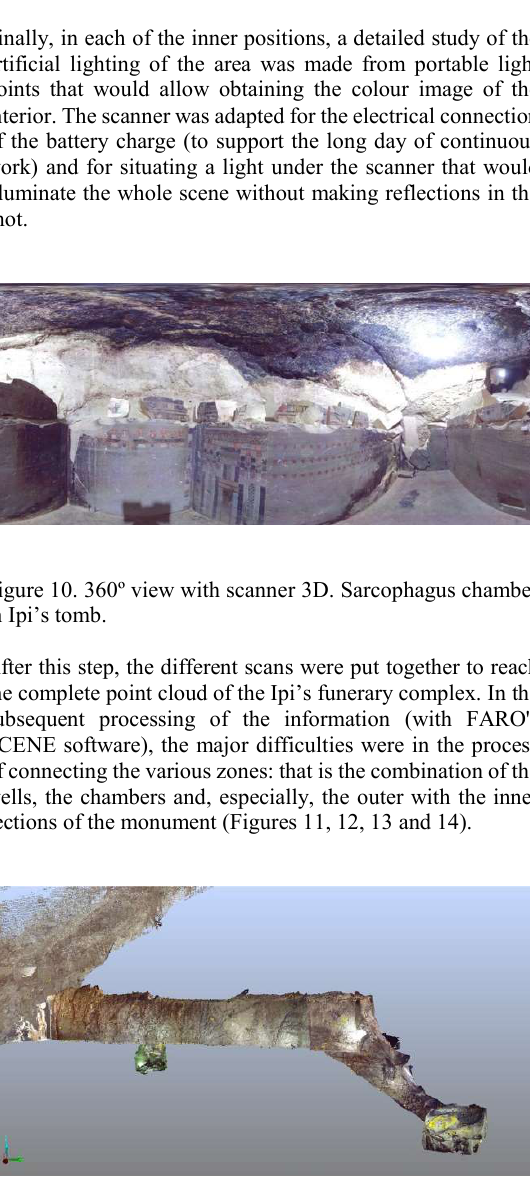
Figure 11. Lateral view of Ipi’s mortuary complex. Scanner Faro focus 3D and SCENE software.